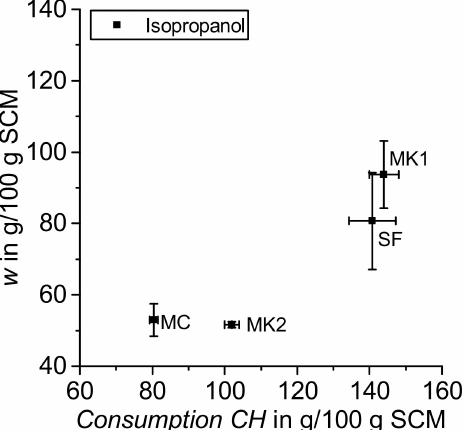
Figure 9. Zoom in of Figure 8: w and Consumption CH